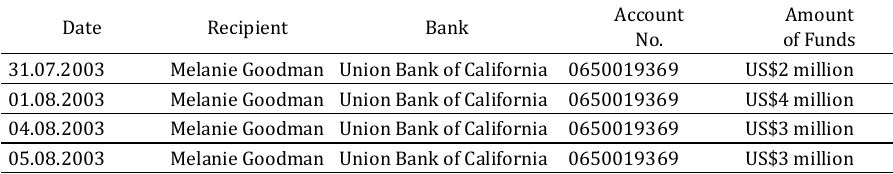
uS$3 million Table 1: The Transfers